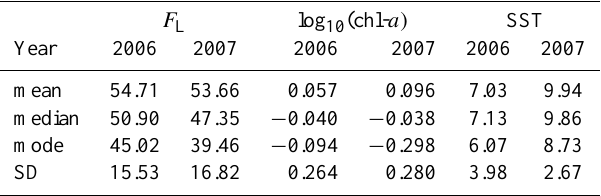
Table 5. Statistical difference in monthly averaged F L , log trans- formed chl- a and SST between August 2006 and August 2007. Mean, median, mode and standard deviation values between 2006 and 2007 were provided. All p -values applied t-tests and Wilcox- son rank sum tests were less than